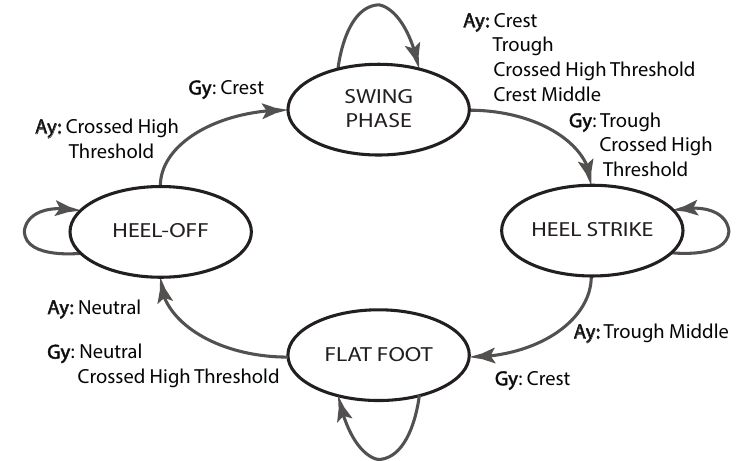
Figure 3. State machine of the threshold-based algorithm. The transition conditions are based on features found in the angular velocity ( G y ) and linear acceleration ( A y )